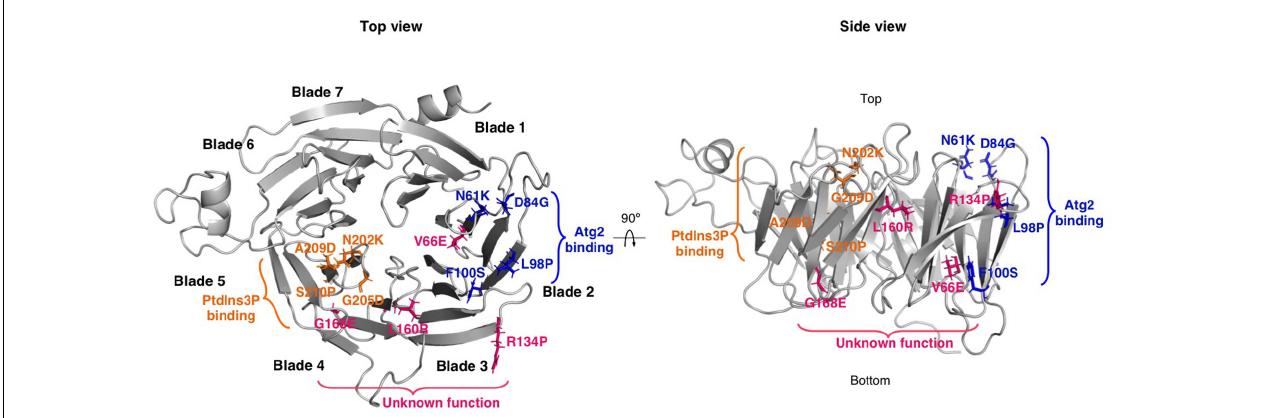
FIGURE 4 | Localization of BPAN missense mutations in the 3D structure of WIPI4. WIPI4 structure was predicted using Robetta (http://robetta.bakerlab.org) based on the structure of WIPI3 (PDB: 6IYY). Top and side views of WIPI4 structure were generated with PyMOL software (The PyMOL Molecular Graphics System, Version 2.4.0 Schrödinger, LLC). Mutated residues localized in the PtdIns3P and ATG2 binding domains are shown as orange and blue sticks, respectively. Other mutated residues are shown as pink